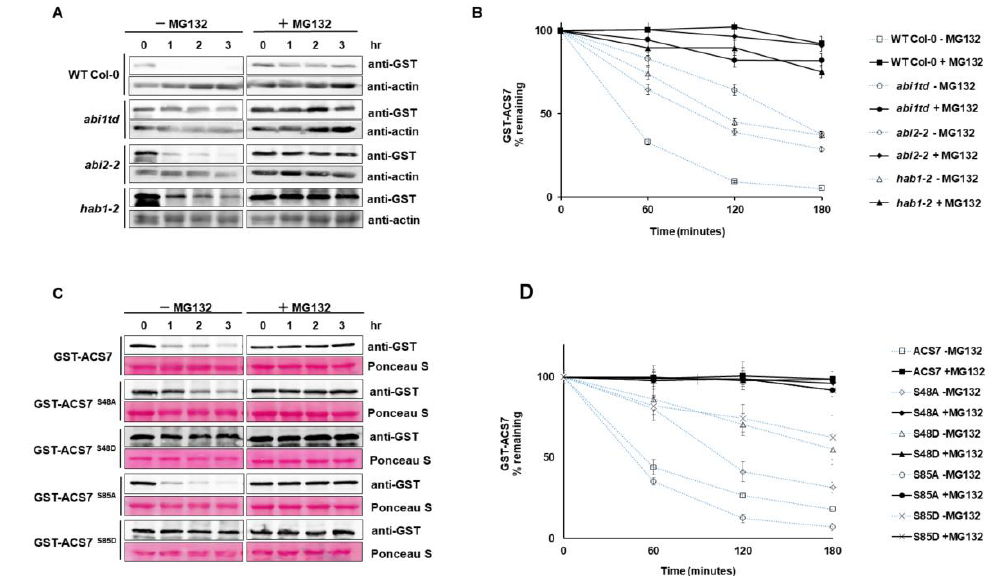
Figure 6. Cell-free degradation assay. ( A ) Protein extracts were prepared from seven-day-old seedlings of WT Col-0, abi1td , abi2 and hab1-1 mutant plants and then incubated with or without MG132, over the indicated time course. The level of recombinant ACS7 was monitored by immunoblotting, using anti-GST antibody. Actin was used as a loading control and was detected by using anti-actin antibody; ( B ) half-life plot for cell-free degradation of GST–ACS7 in WT Col-0, abi1td , abi2 and hab1-1 extracts; ( C ) cell-free degradation assay of mutated and nonmutated ACS7 in wild-type protein extracts. The level of recombinant ACS7 was monitored by immunoblotting, using anti-GST antibody. Ponceau staining was used as a loading control; ( D ) half-life plot for cell-free degradation of GST–ACS7, GST–ACS7 S48A, S48D, S85A and S85D mutant. ACS7 protein bands were quantified, using ImageJ software, and normalized, to the control (mock) band (set as